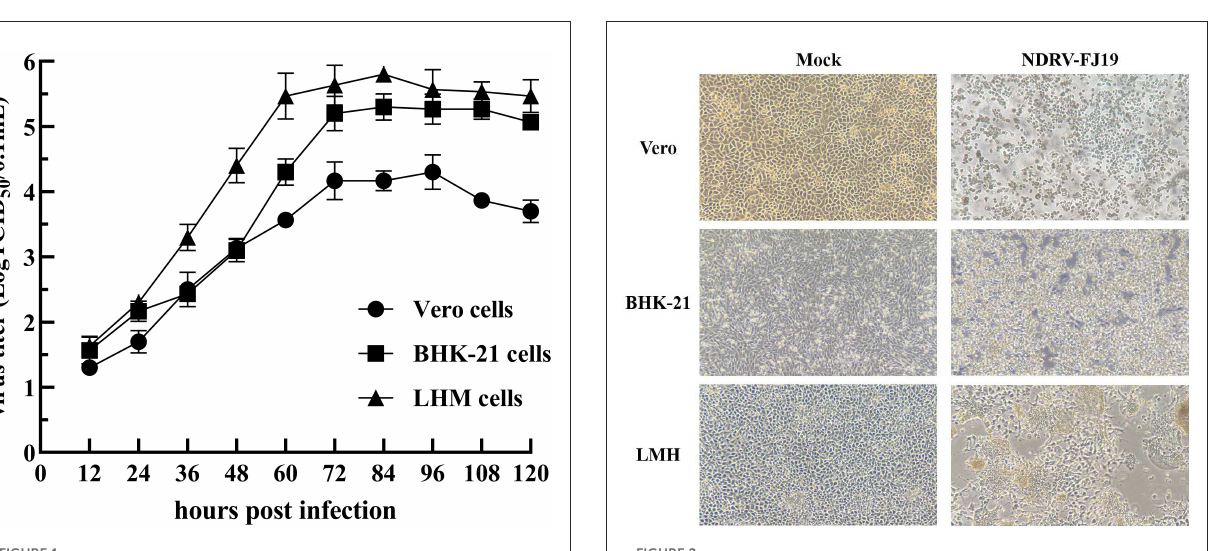
NDRV-LRS-GD20, and NDRV-ZSS-FJ20 genomes were deposited into GenBank under accession numbers